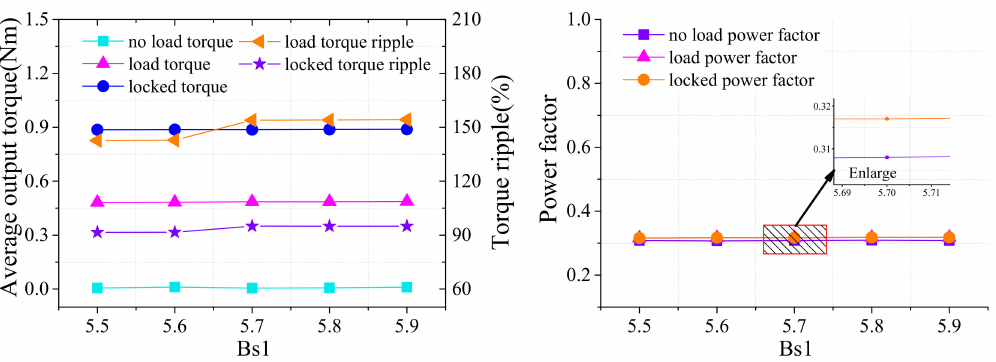
Figure 8. Influence of slot width on average output torque and power factor at no load, load, and locked.